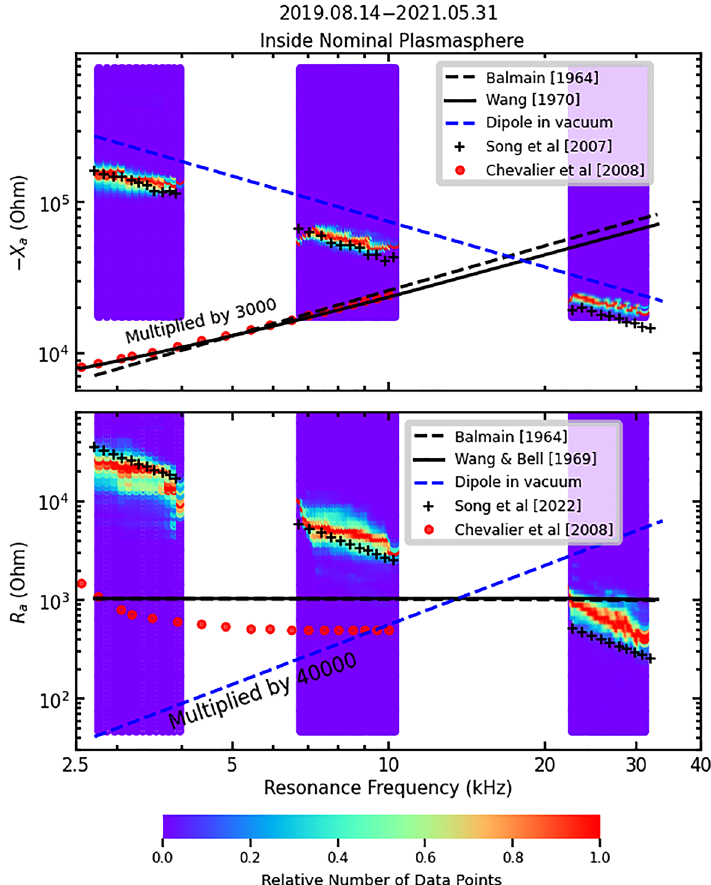
Figure 2. Comparison of DSX results adapted from Fig. 1 with the prediction of the radiation impedance in vacuum 18 , blue dashed-lines, Balmain model 19 , black dashed line, and Wang and Bell models 20,28 , black solid lines. Black plus-signs in the upper panel show the antenna reactance predicted by Song et al. antenna sheath model 22 and those in the lower panel show the radiation resistance predicted by Song et al. whistler radiation model 24